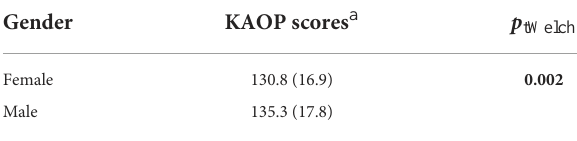
TABLE 5 The KAOP scores grouped by age group, N = 803.